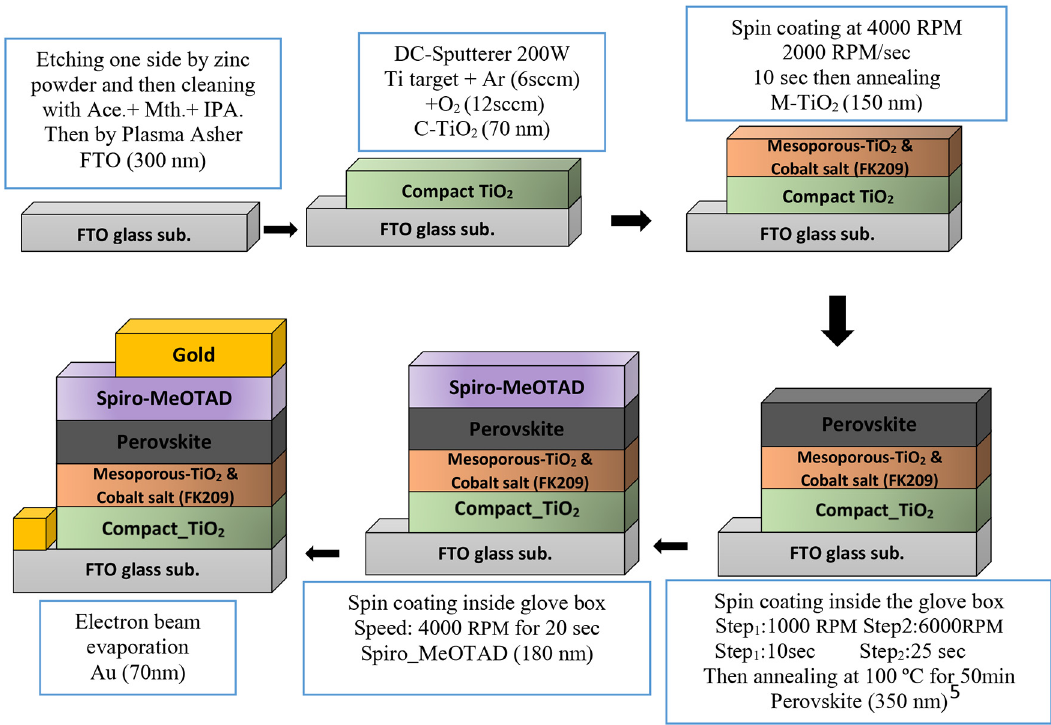
Fig. 1. Schematic steps for the fabrication procedure followed to construct the PvSCs. The compact TiO 2 was DC sputtered in an Ar/O 2 plasma. The perovskite is prepared inside a N 2 atmosphere glove